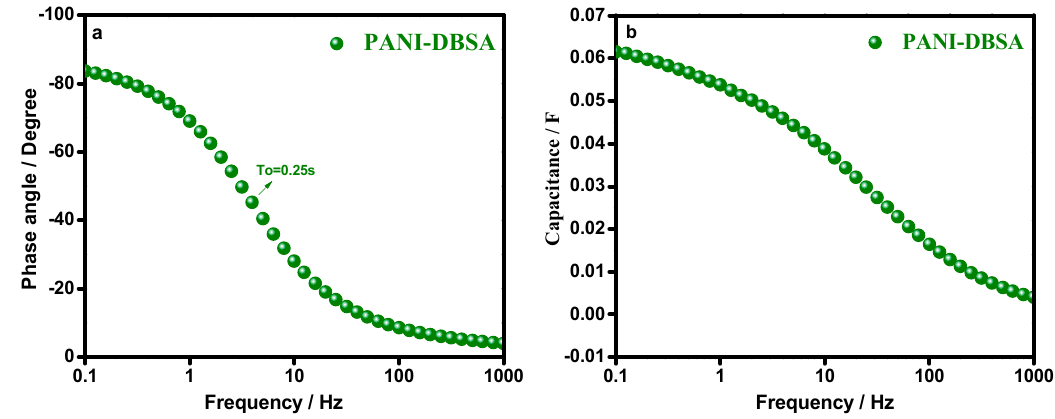
Figure 8. ( a ) Bode Plot with a relaxation time constant ( τ o ) and ( b ) capacitance vs. frequency response, of the synthesized PANI–DBSA.